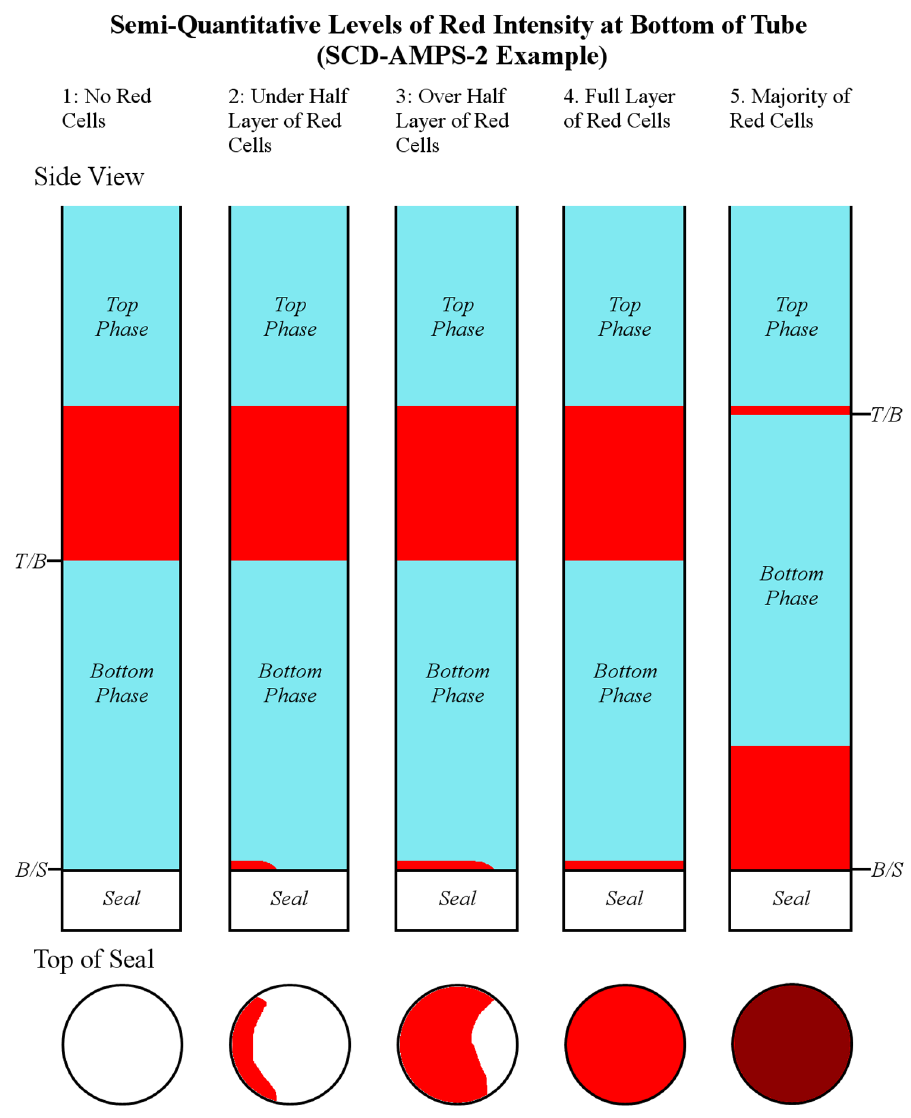
Fig. 2. Schematic representation of the five levels of evaluation of the bottom of an SCD-AMPS test. Levels 1 through 5 correspond to increasing levels of accumulation of red cells at the interface between the bottom phase and the seal ( B/S ) compared to the accumulation of red cells at the interface between the top and bottom phase ( T/B